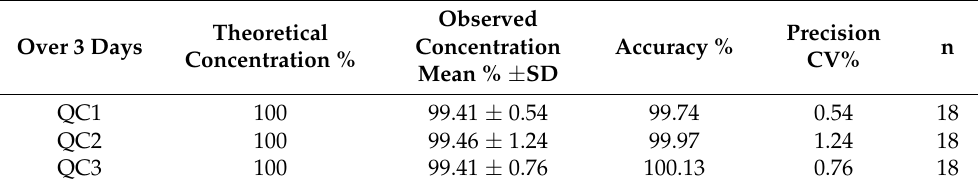
Table 6. Results of inter-day analyses of 3 quality control samples of various concentrations of propofol solutions in methanol.